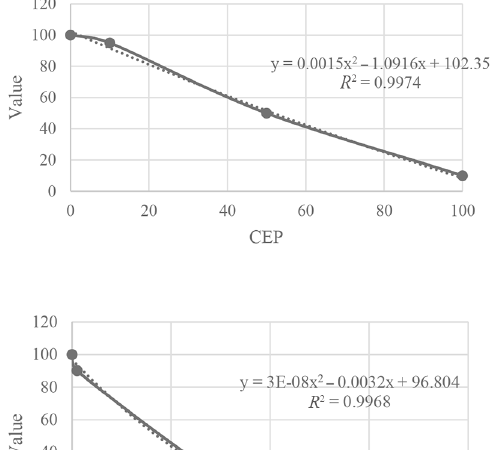
Figure 8. Unit cost value function